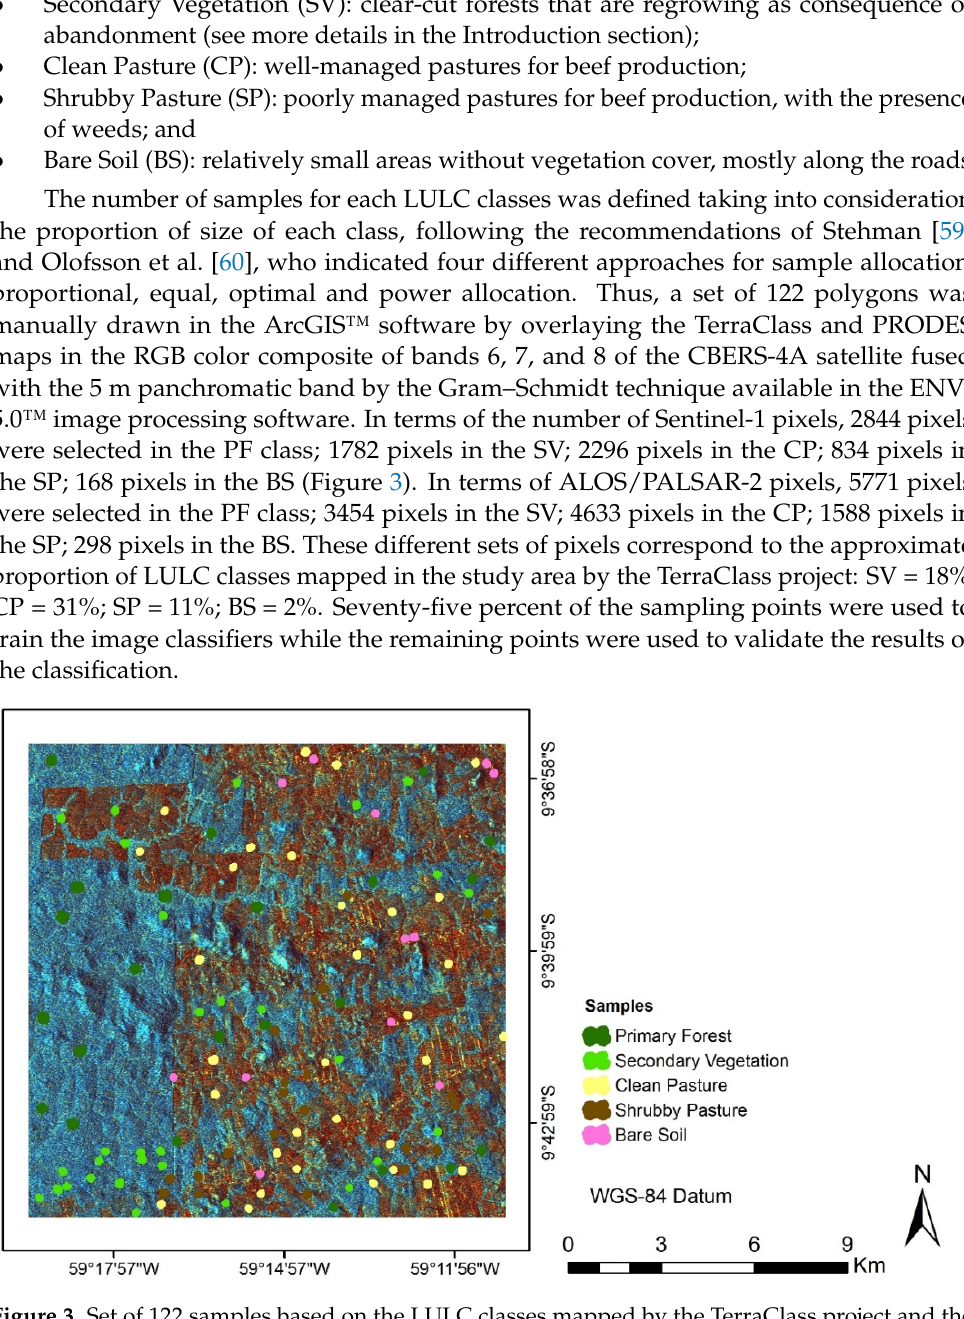
Figure 3. Set of 122 samples based on the LULC classes mapped by the TerraClass project and the deforestation data produced by the PRODES project. The RGB color composite corresponds to the ALOS/PALSAR-2 data (R: HH/HV; G: HH; B: HV).